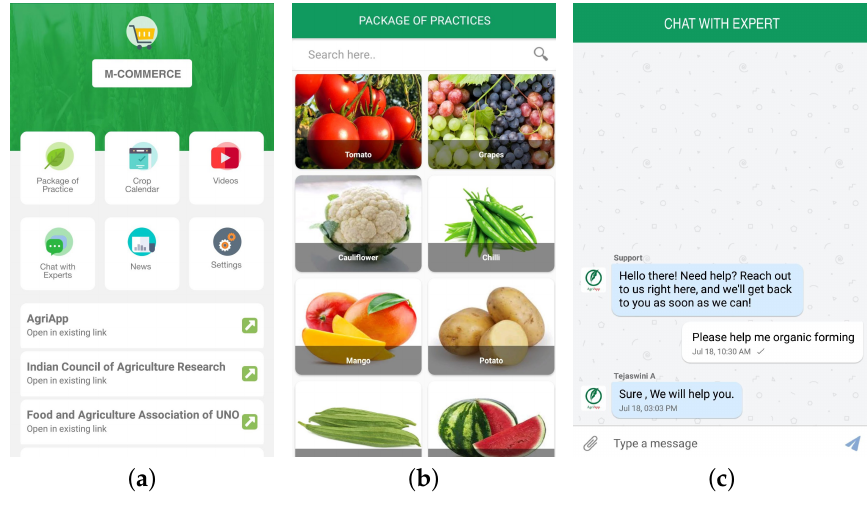
Figure 39. AgriApp: ( a ) Main menu; ( b ) Package of practices; ( c ) Chat with